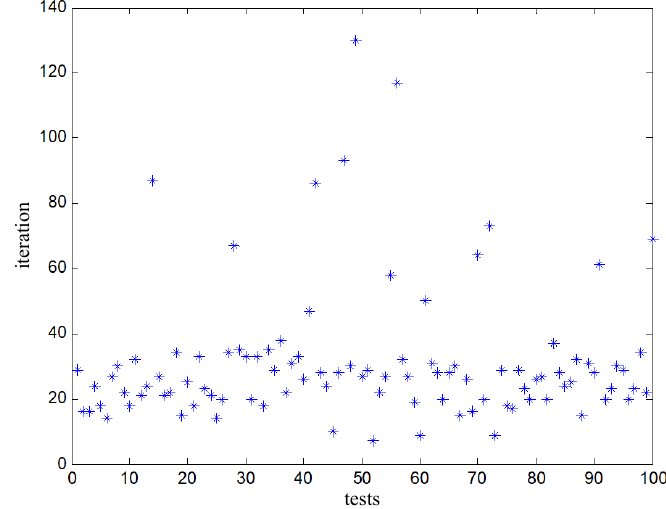
Figure 9. The number of iterations of each